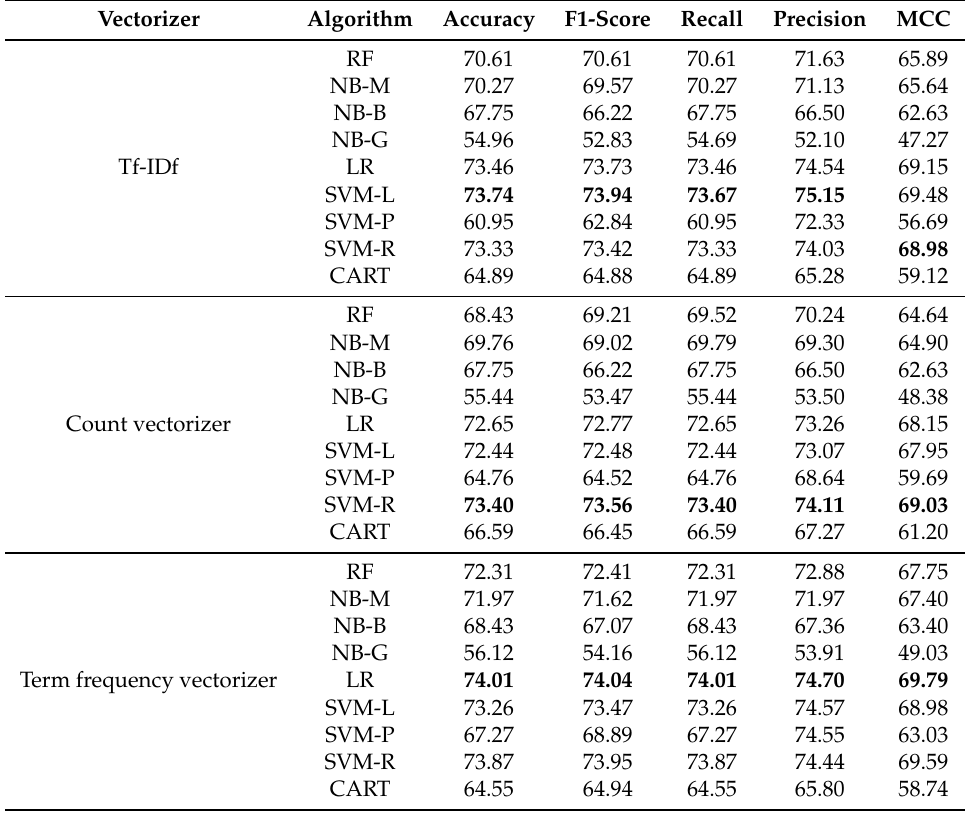
Table 6. Validation results on Nisha Madhulika’s